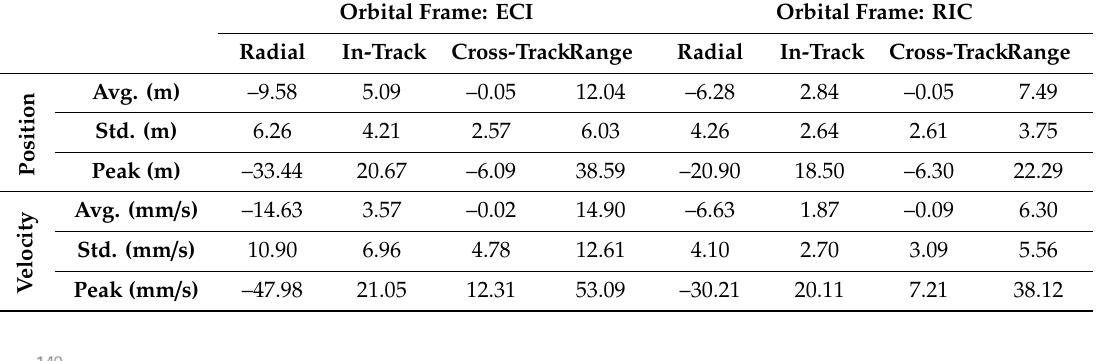
Table 2. Performance analysis results of on-board orbit determination with respect to reference orbit from GPS simulator. Orbital Frame: ECI Orbital Frame: RIC Radial In-Track Cross-TrackRange Radial In-Track Cross-TrackRange